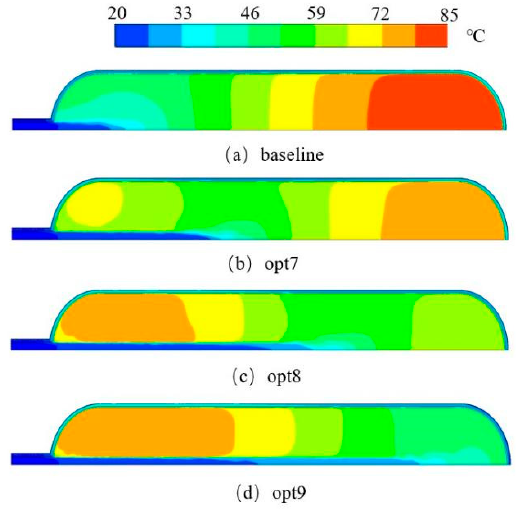
Figure 9. Temperature and velocity contour of hydrogen inside the cylinder at 80 s.